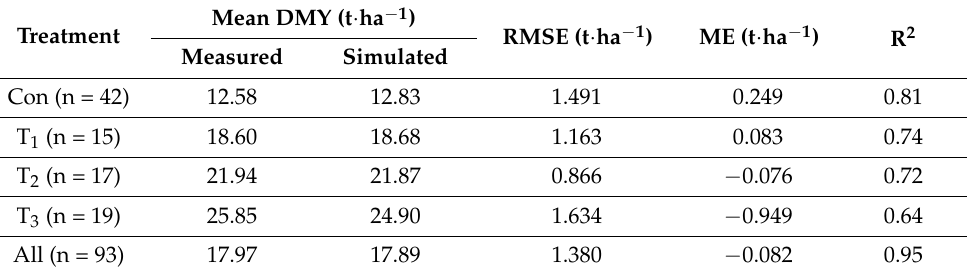
Table 4. Mean simulated and observed Napier grass DMY values in t·ha − 1 according to crop site treatments and statistical analysis results (RMSE, ME, and R 2 ).